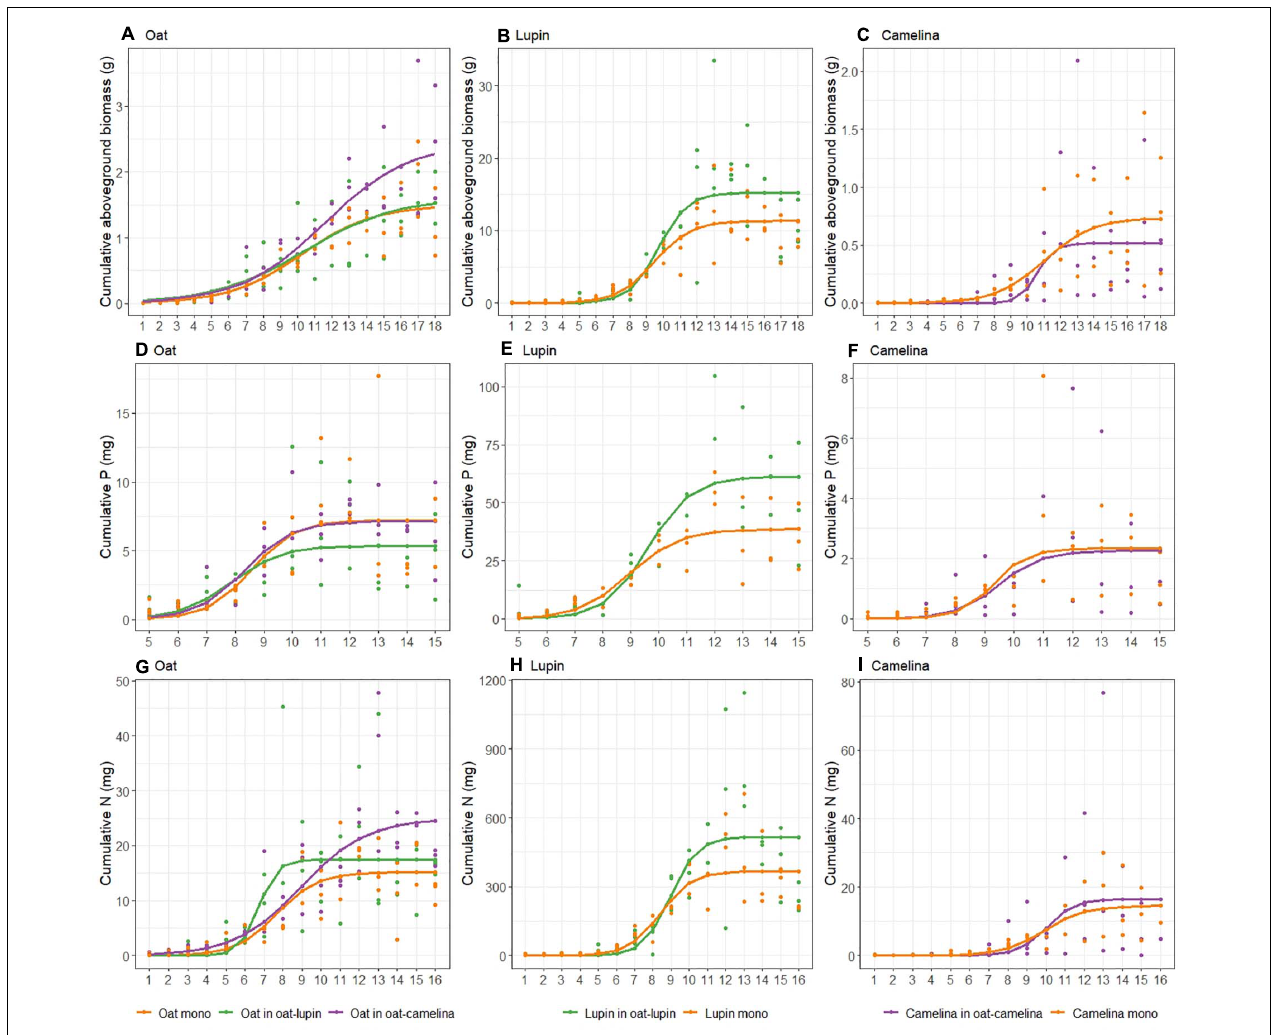
FIGURE 1 | Trajectories of cumulative aboveground biomass (A–C) , P (D–F) and N (G–I) uptake of oat with lupin [ (A,D,G) : green], oat with camelina [ (A,D,G) : purple], lupin (B,E,H) , and camelina (C,F,I) when grown in mixture (purple and green) and in monoculture (orange). Curves were derived from Eq. 1. Points show actual data. Note different y -axis